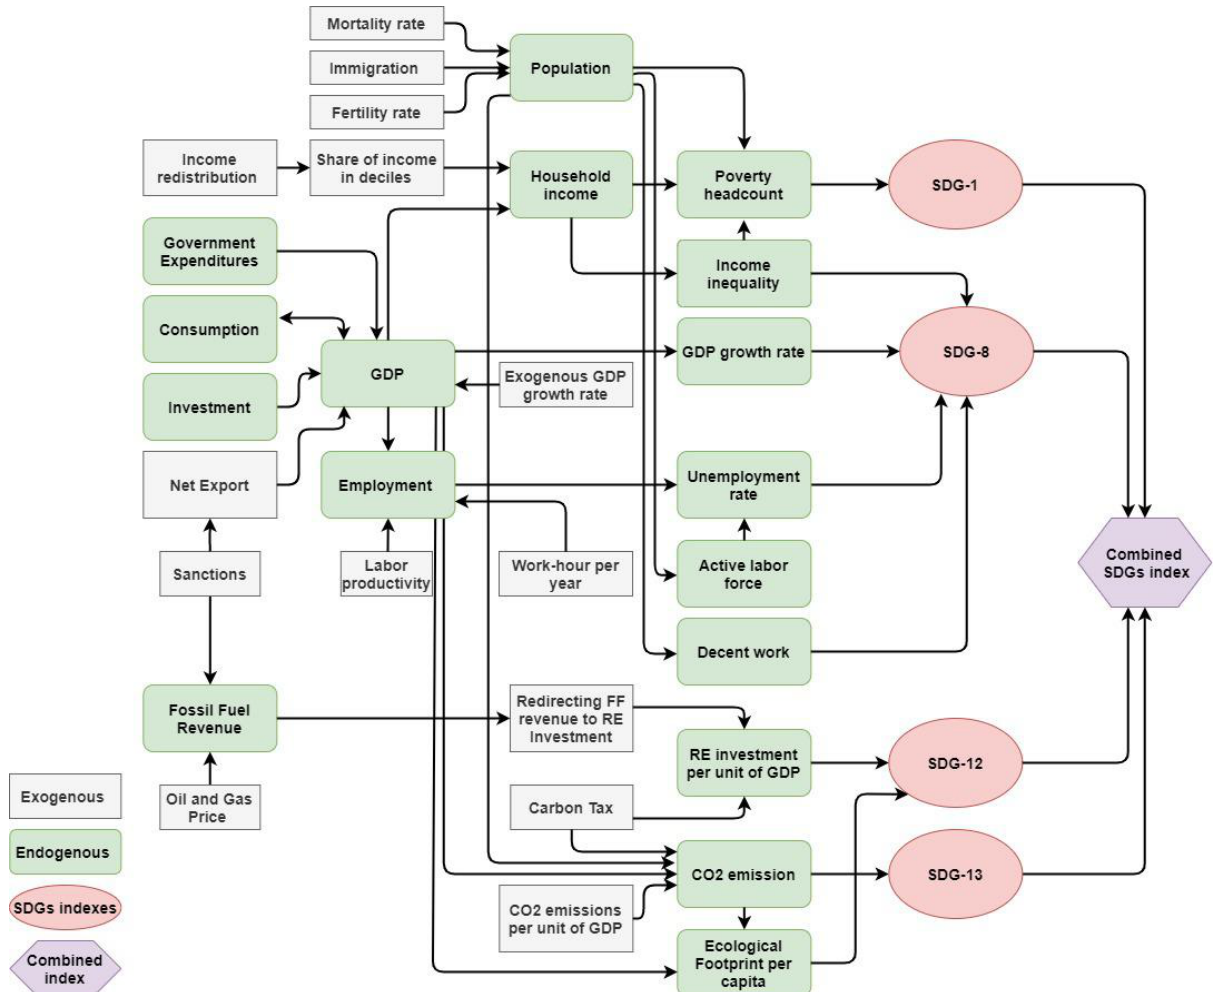
Figure 3. Overview of the SDGs model of